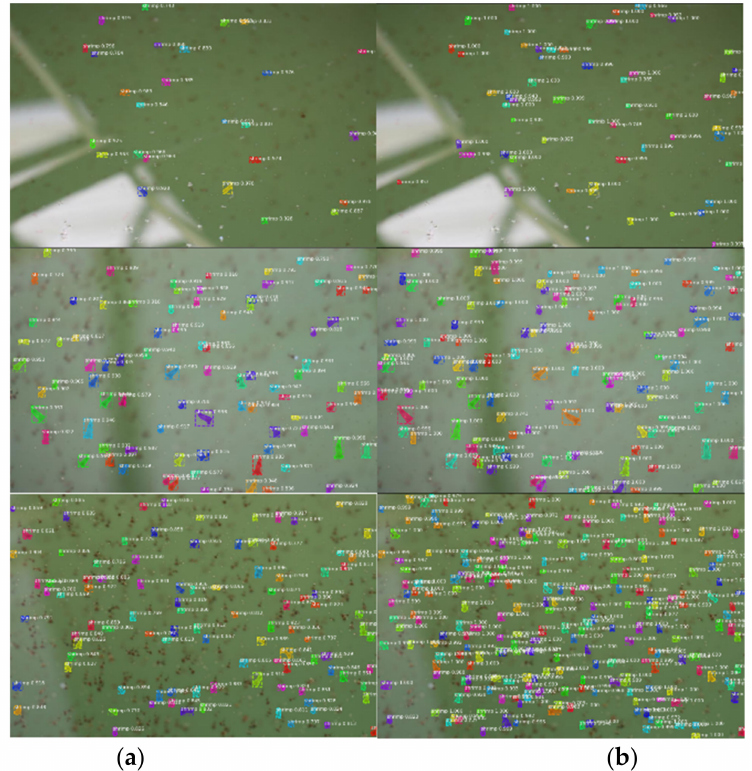
Figure 15. Comparison of the results of shrimps by using the ( a ) default Mask R-CNN model and ( b ) improved Mask R-CNN model. The images of shrimp by density: row 1, less dense with the predicted number of shrimps of 26 (GT = 26) in ( a ) and 55 (GT = 55) in ( b ); row 2, medium dense with the predicted number of shrimps of 83 (GT = 84) in ( a ) and 97 (GT = 99) in (b); row 3, high dense with the predicted number of shrimps of 100 (GT = 104) in ( a ) and 213 (GT = 256) in ( b